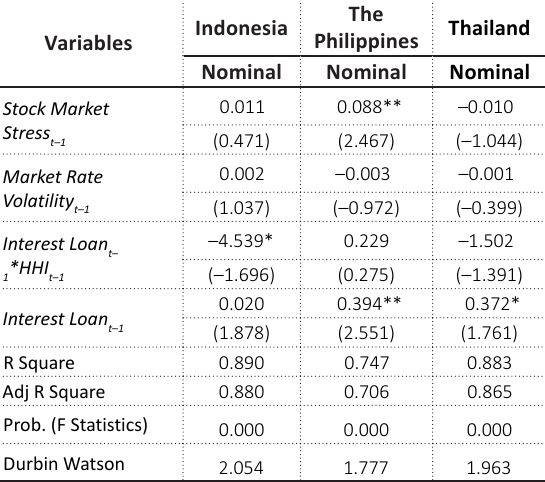
Table 4 (cont.). Regression results of the Time Deposit